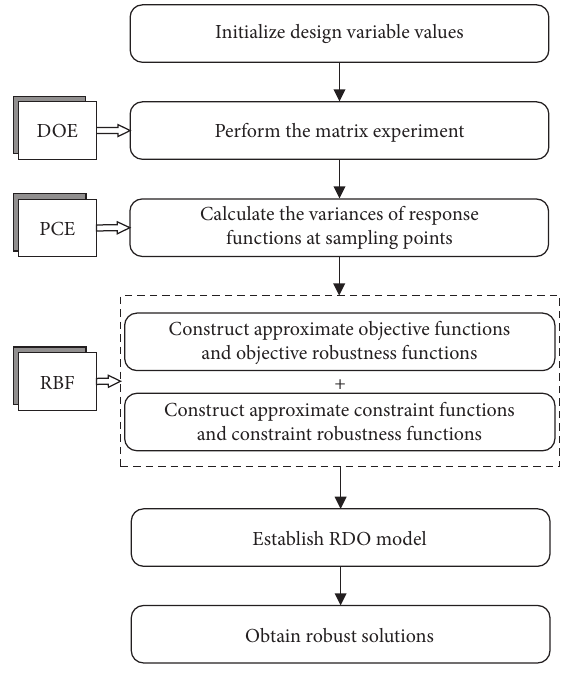
Figure 1: Framework of robust design